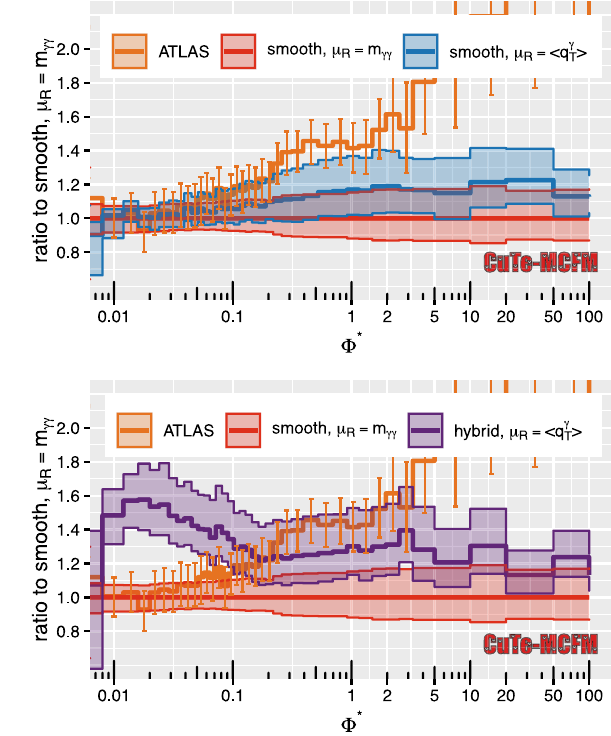
Fig. 5 Fully matched q T spectra at N 3 LL (cid:2) + NNLO in comparison with the ATLAS measurement. Top plot: Ratio to N 3 LL (cid:2) with smooth- cone isolation and μ R = m γγ in comparison with data and μ R = (cid:8) q Bottom plot: Similar, but in comparison with prediction using hybrid- γ (cid:9) cone isolation and μ R = (cid:8) q T